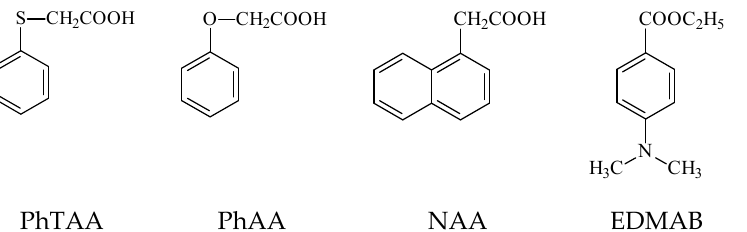
Figure 8. Co-initiator structures used in the photopolymerizable compositions: (phenylthio)acetic acid (PhTAA), 1-naphthoxyacetic acid (NAA), phenoxyacetic acid (PhAA), and ethyl 4-dimethylaminobenzoate (EDMAB).